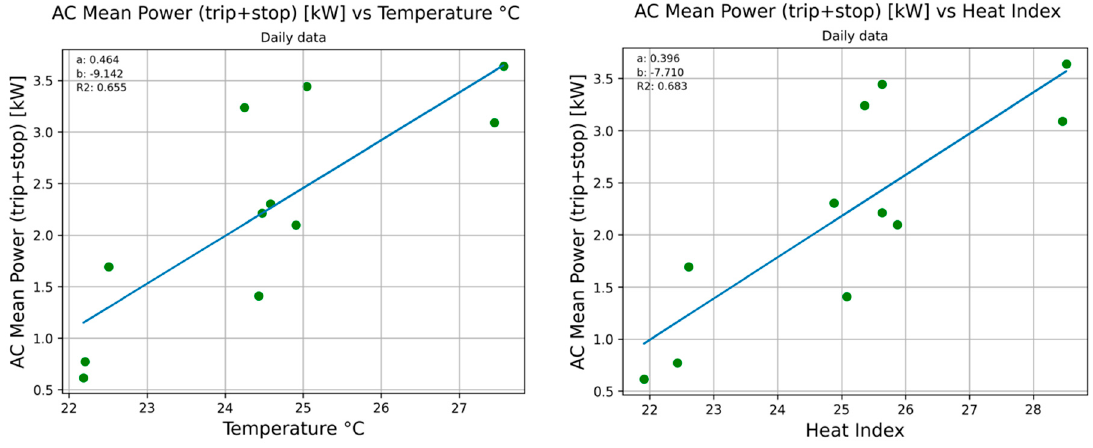
Figure 3. As Figure 2 for daily average values.